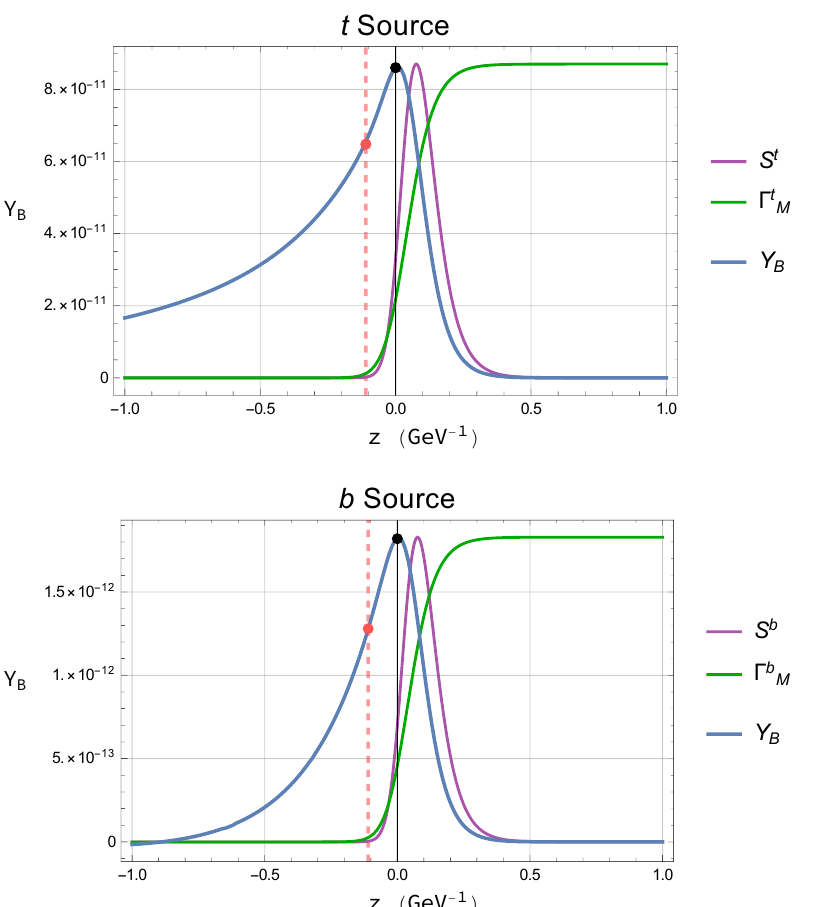
Figure 6. Y B with a top source (upper plot) and a bottom source (lower plot) as a function of the position of the bubble wall, together with their sources S t/b and Γ t/b